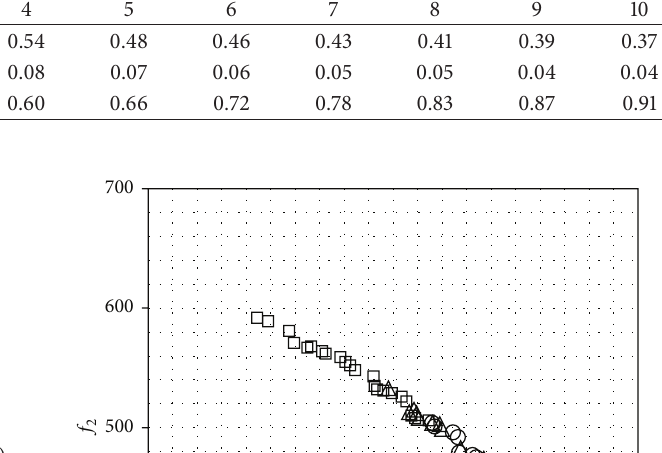
Figure 5: Distribution of the component loadings (Modes 1 to 8).